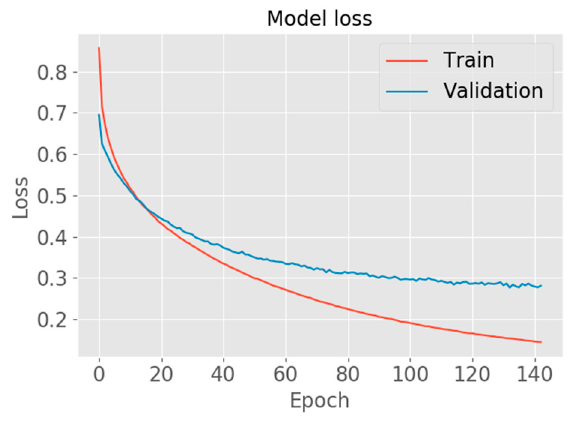
Figure 18. Model learning curve showing the reduction in training data error and validation data error over the GRU model training process.